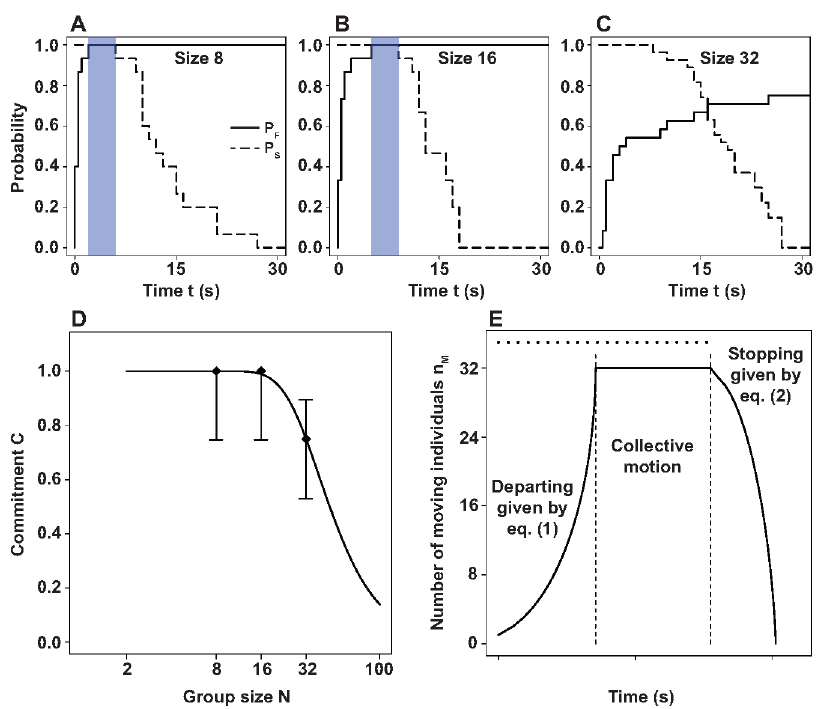
Fig 3. Following latency versus stimulus duration and model fitting. (A-C) Probability P F of observing a first follow event before time t (solid line) and probability P S that the initiator has not reached the target at t (dashed line) for group sizes N = 8, 16, and 32. The blue areas indicate the time window between the maximum departure time for the first follower and the minimum required time for the initiator to reach the target. (D) Probability that the initiator is followed by at least one naive sheep (referred to as commitment) as a function of group size N in experiments (black diamonds) and as predicted by Eq (3) (black line). Whiskers represent 95% confidence intervals. (E) Predicted values of n M (t)) for N = 32. The dotted line indicates the time required by the initiator to reach the target ( τ